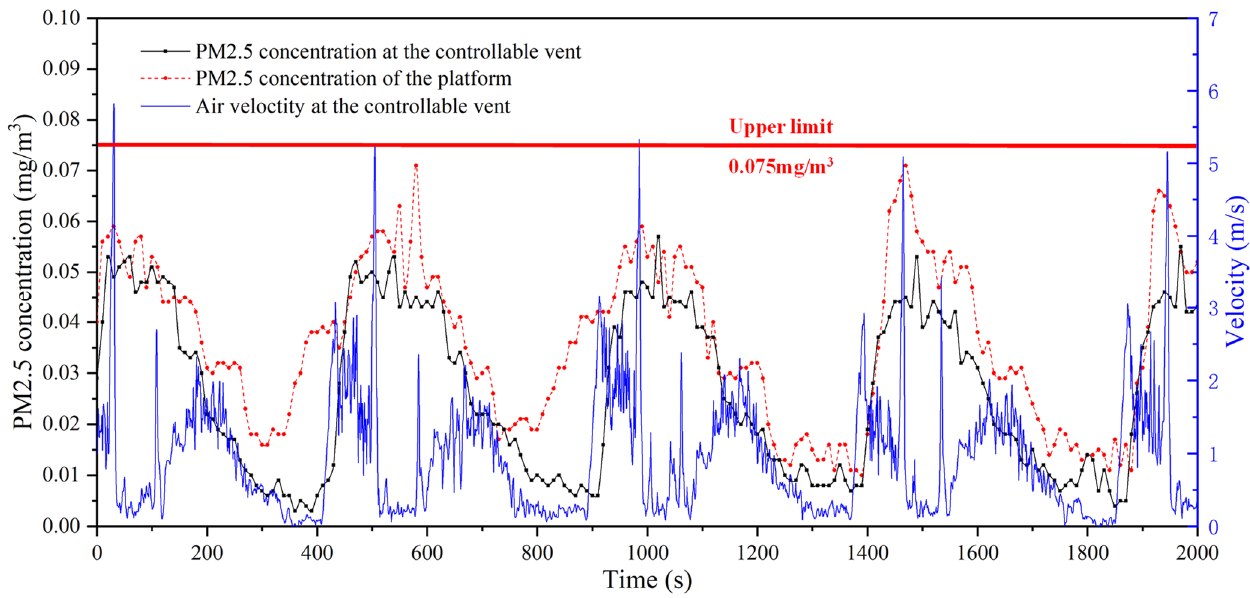
Figure 3. Variations in the PM2.5 concentration and air velocity.